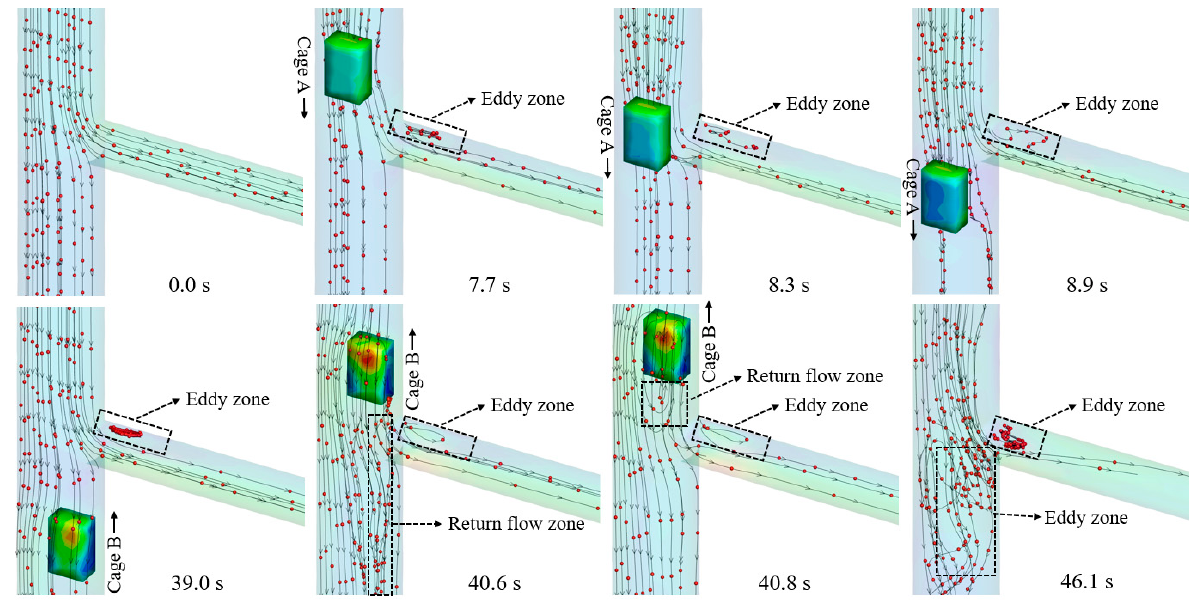
Figure 6. Trace diagram of airflow structure in 1765.0 m lane under piston effect.